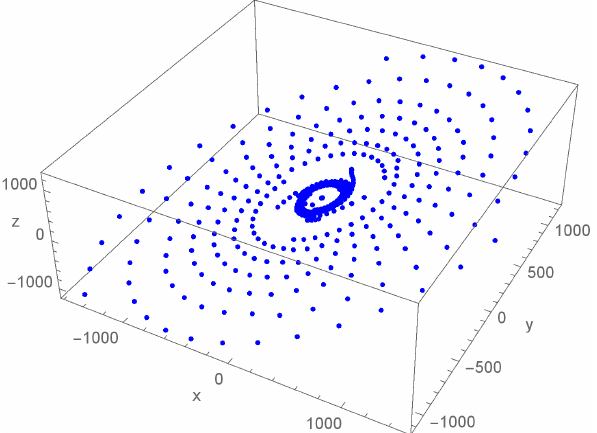
Figure 27. 3D attractor dot plot of x n , y n , z n for α = 0.00001, β = 2.0, γ = 3.0, δ = 4.0, ζ = 0.00005, η = 6.0, µ = 7.0, ε = 0.00009, υ = 8.0, ρ = 10.0, σ = 11.0, ω = 12.0. with initial conditions x 0 = 1.0, y 0 = 2.0 and z 0 = 3.0.